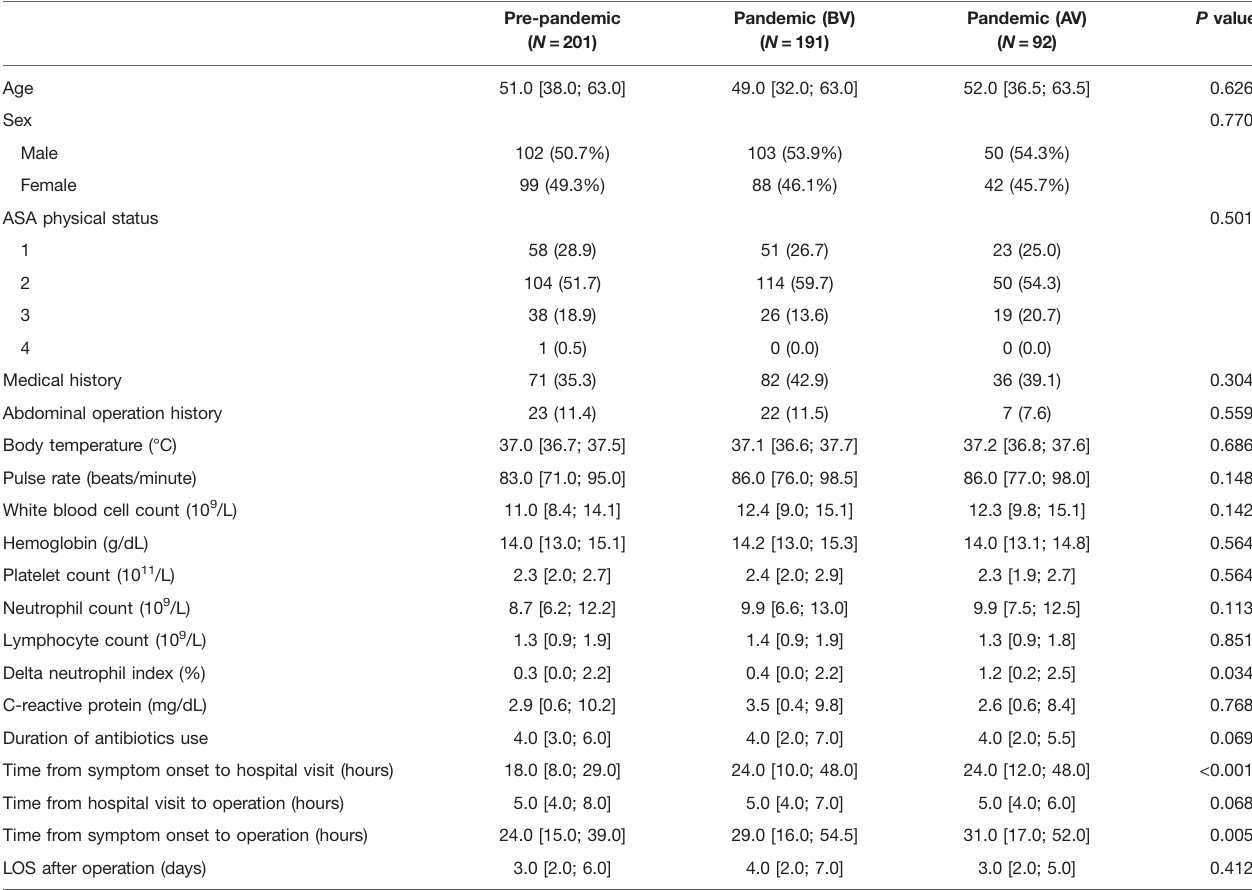
TABLE 1 | Demographic characteristics of enrolled